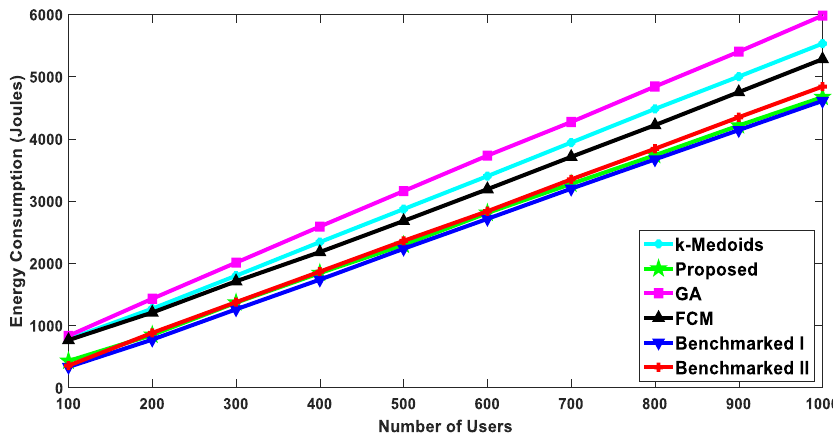
Figure 17. Energy consumption: comparison with the benchmarked schemes ( 𝑤 1 = 𝑤 2 = 0.1,𝑤 3 = 0.8 ). Sensors 2020 , 20 , 5509